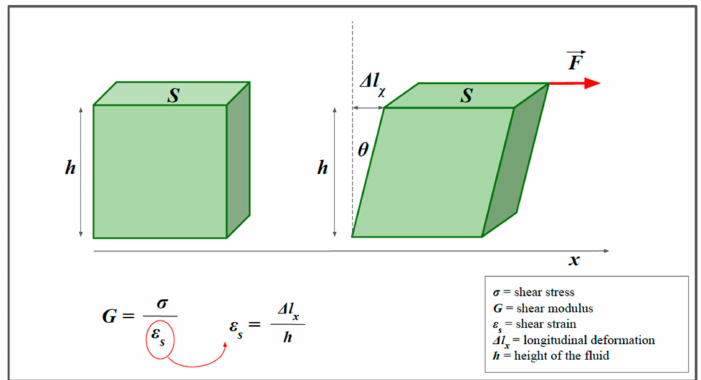
Figure 6. Shear strain. The model helps to visualize the concept of shear stress. We consider a prism of elastic material and a shear force F (red arrow), applied parallel to the x -axis. Similarly to the calculations for Young’s modulus ( E ), it is possible to describe a quantity, which we define as G , to indicate the shear modulus. G is the constant of proportionality between the shear stress and the shear strain. The transverse strain can also be expressed as a function of the angle, θ .